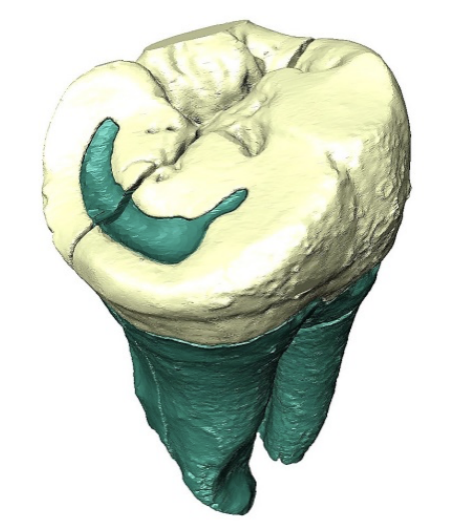
Figure 1. 3D reconstruction of sample 269 with highlighted enamel (yellow) and dentine (green)